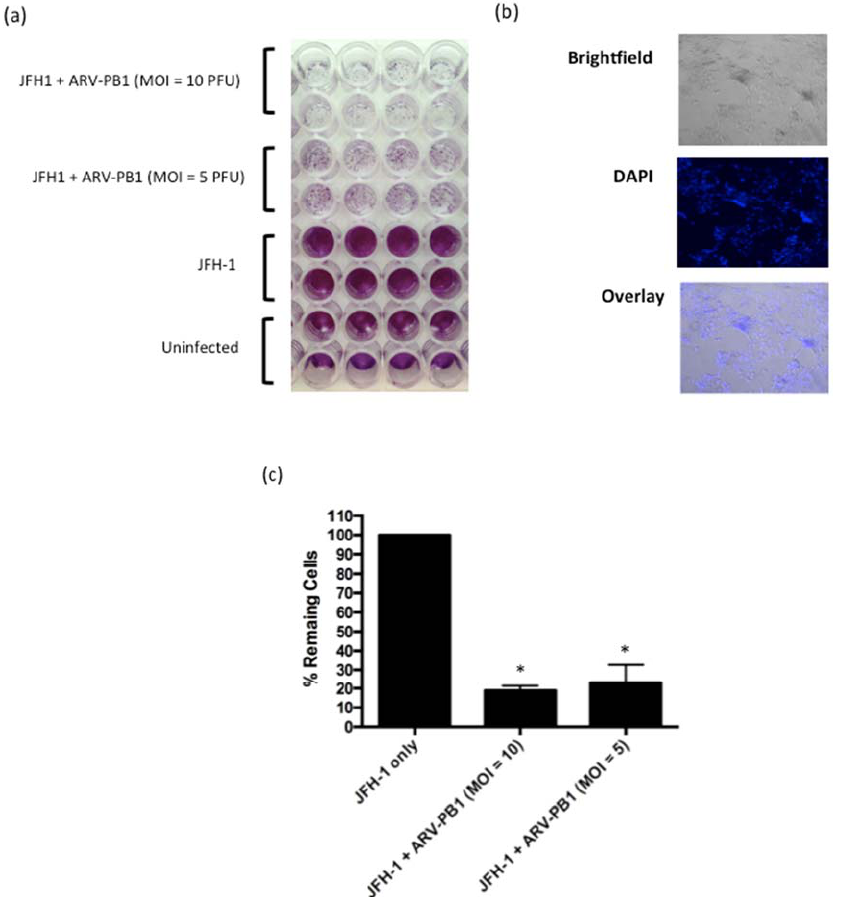
Figure 7. ARV ‐ PB1 activity in JFH ‐ 1 ‐ infected cells. ( a ) Huh ‐ 7.5.1 cells were infected with JFH ‐ 1